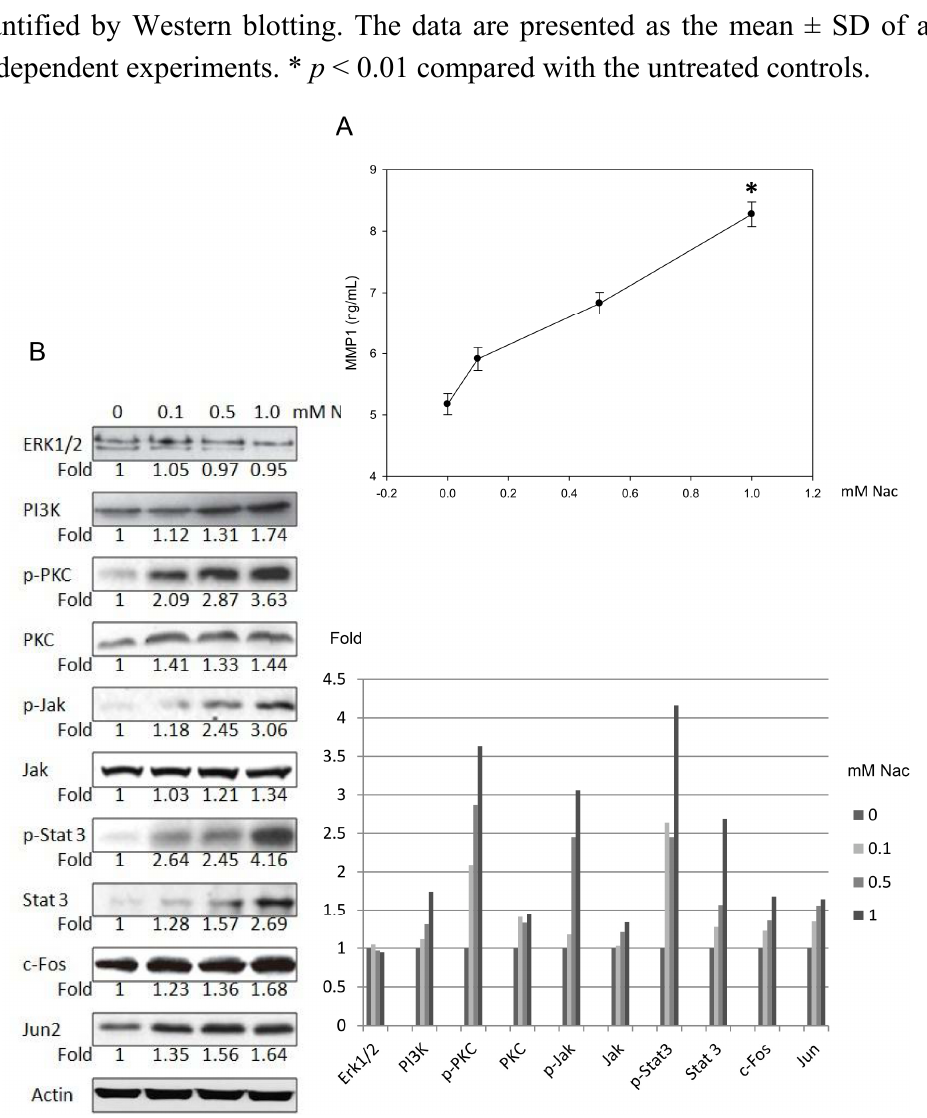
Figure 5. The expressions of Matrixmetalloproteinase-1 (MMP-1), extracellular signal-regulated protein kinases 1 and 2 (Erk1/2), phosphatidylinositol 3-kinase (PI3K),